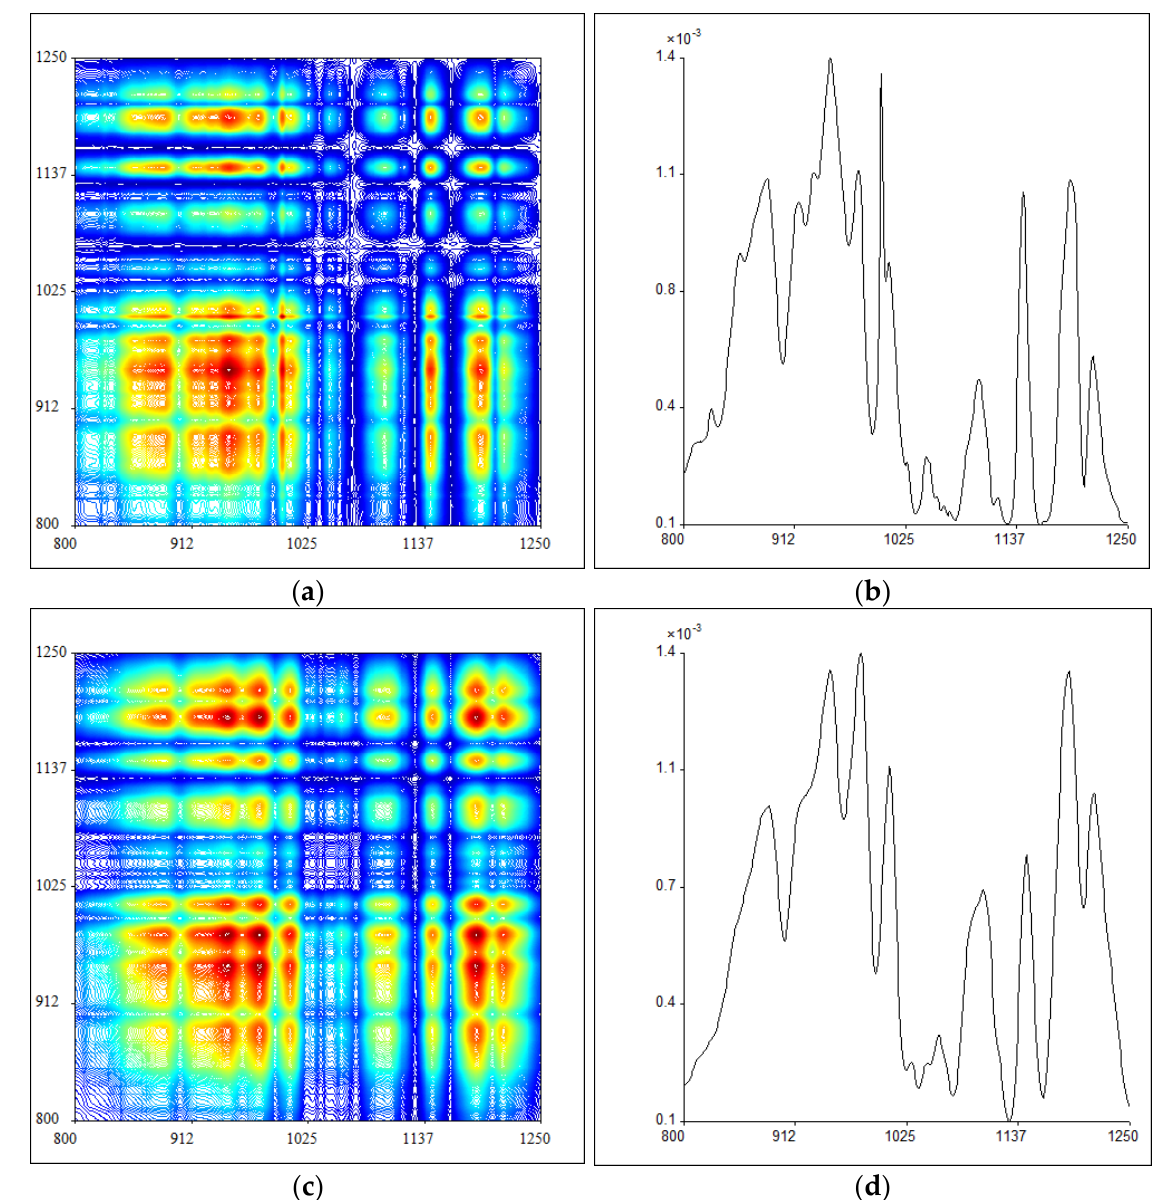
Figure 3. The synchronous two-dimensional correlation infrared (2DIR) spectra of pterocarpus bracelet (PB) ( a ) and P. santalinus ( c ) at 800–1250 cm − 1 and the corresponding automatic peaks distribution of pterocarpus bracelet (PB) ( b ) and P. santalinus ( d ). Table 2. Autopeak intensity in the two-dimensional correlation infrared (2DIR) spectra of pterocarpus bracelet (PB) (A) and P. santalinus (B) at 800–1250 cm − 1.